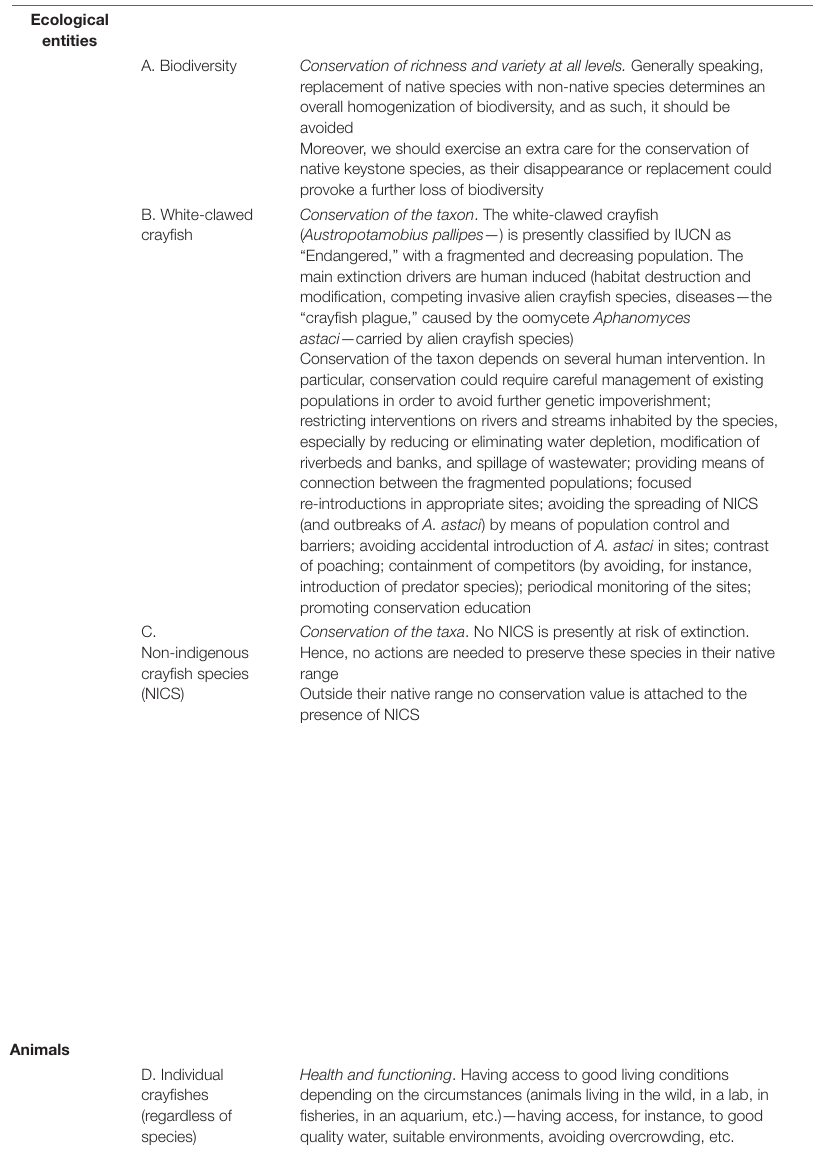
TABLE 2 | Example of EM—ethical assessment of conservation of A. pallipes [modified from Biasetti et al. (2021)]. 1.